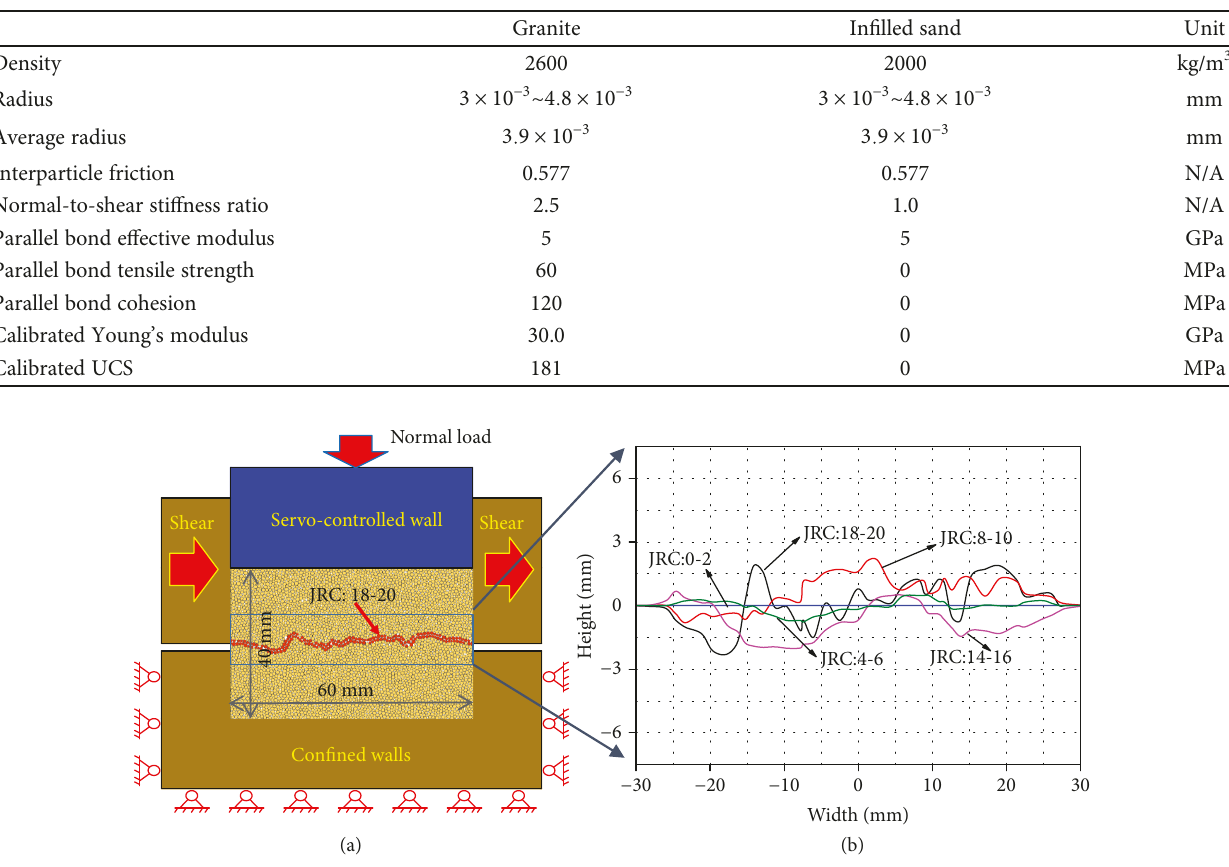
Table 1: Mechanical and physical parameters of granite and in fi